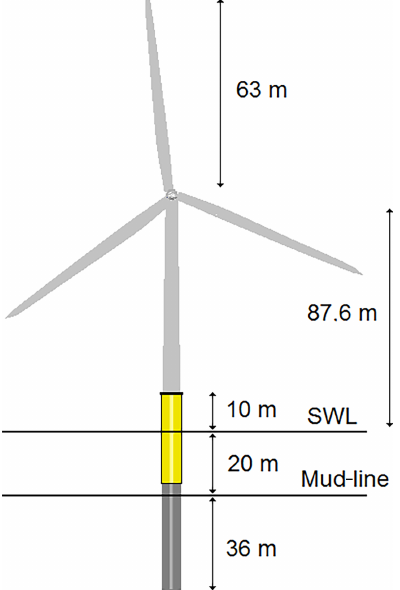
Figure 8. Dimensions of the NREL 5MW wind turbine, with monopile foundation.